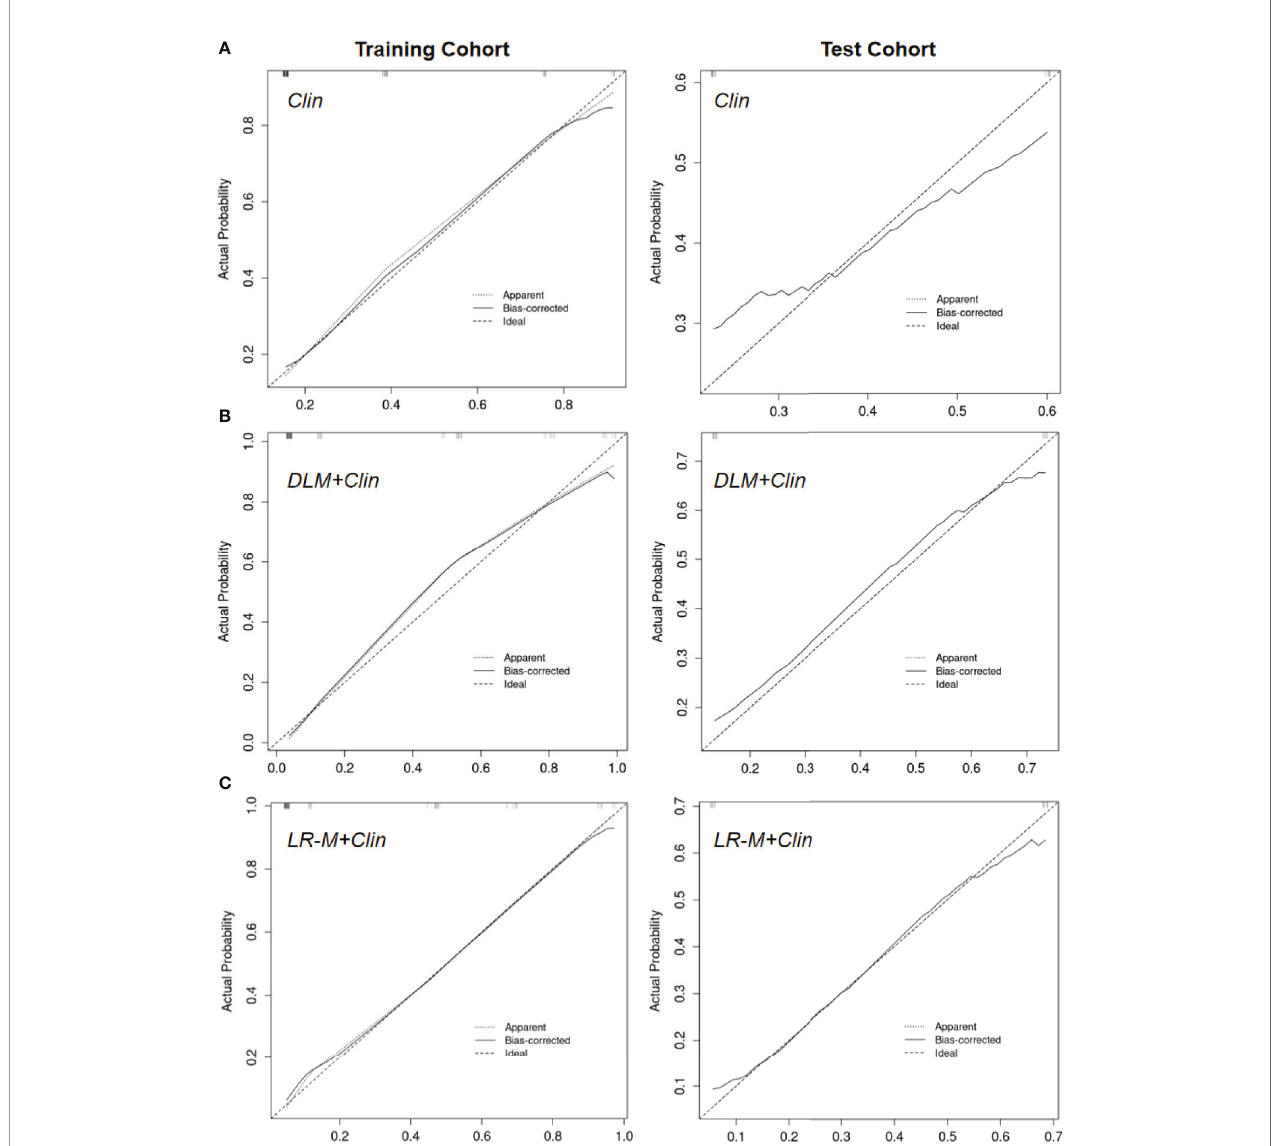
FIGURE 5 | Calibration curve of Clin (A) , US-DLM+Clin (B) and MRI LR-M (C) model for predicting probability of OM in the training cohort and test cohort. Clin, clinical features; DLM, deep learning model; LR-M, liver imaging and reporting system